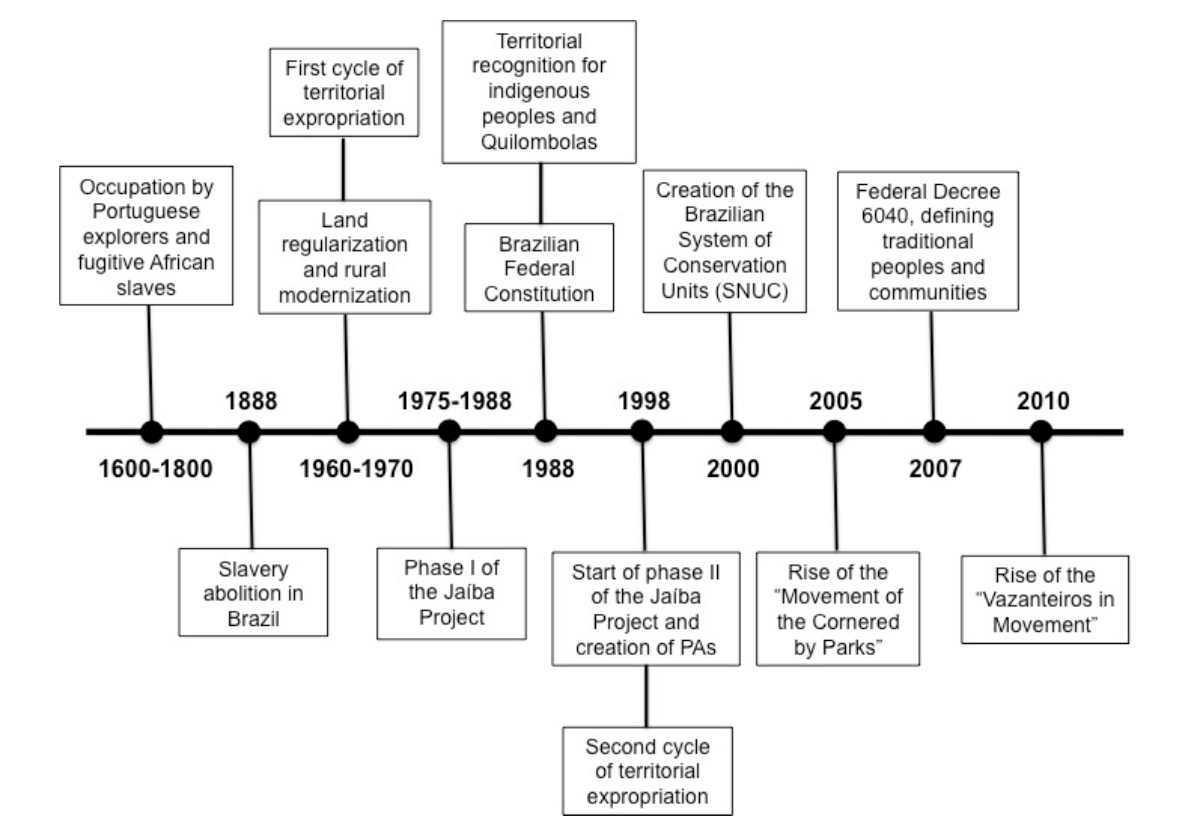
Fig. 2 . Timeline of the main events affecting the traditional communities of Pau Preto, Pau de Légua, and Quilombo da Lapinha in the north of the Minas Gerais State,